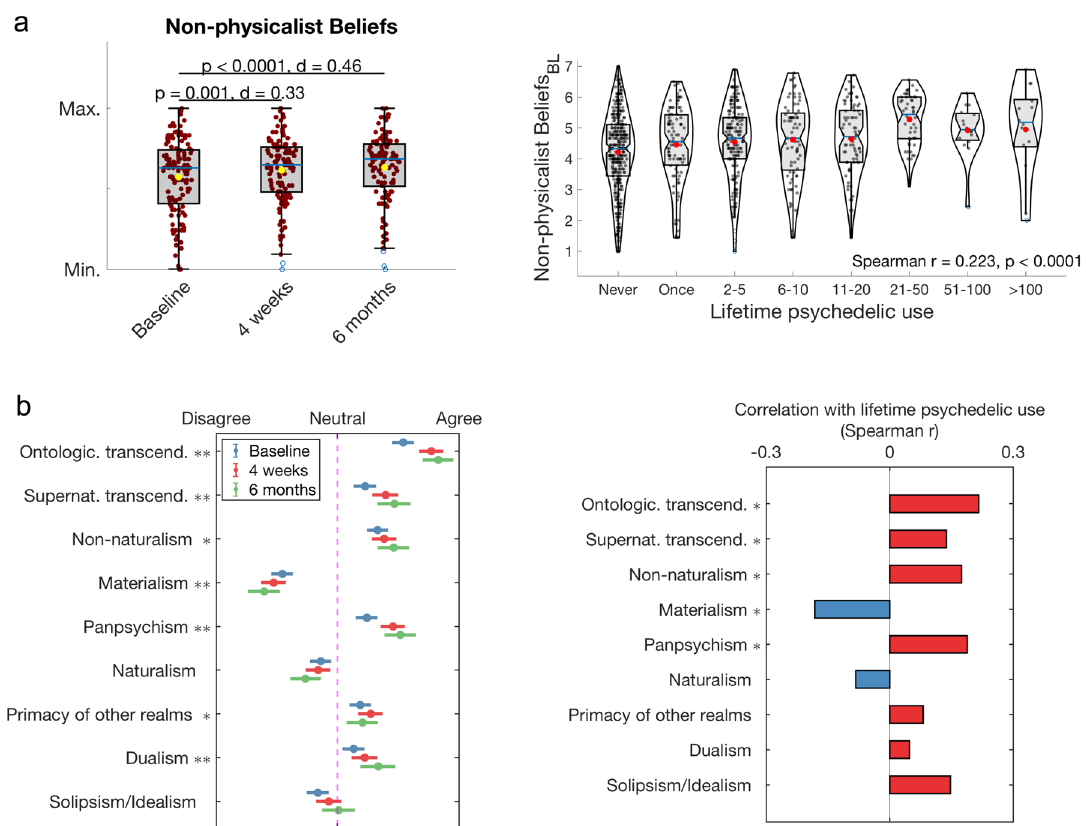
Figure 1. Psychedelic use is associated with shifts in metaphysical beliefs away from hard physicalism or materialism. Attending a psychedelic ceremony was associated with shifts away from hard-materialistic views ( a -left), and items associated with transcendentalism, non-naturalism, panpsychism, primacy of other realms, dualism and solipsism/idealism ( b -left), with some changes enduring up to 6 months (Bonferroni- corrected). Additionally, significant positive relationships were observed between lifetime psychedelic use and baseline scores on metaphysical beliefs ( a -right), and items referring to transcendentalism, non-naturalism, and panpsychism, while a negative relationship was found with materialism ( b -right). ( b -left: mean values and standard errors displayed. *Significant change at 4 weeks; **significant change at 6 months, Bonferroni- corrected; b -right: * p < 0.0001,